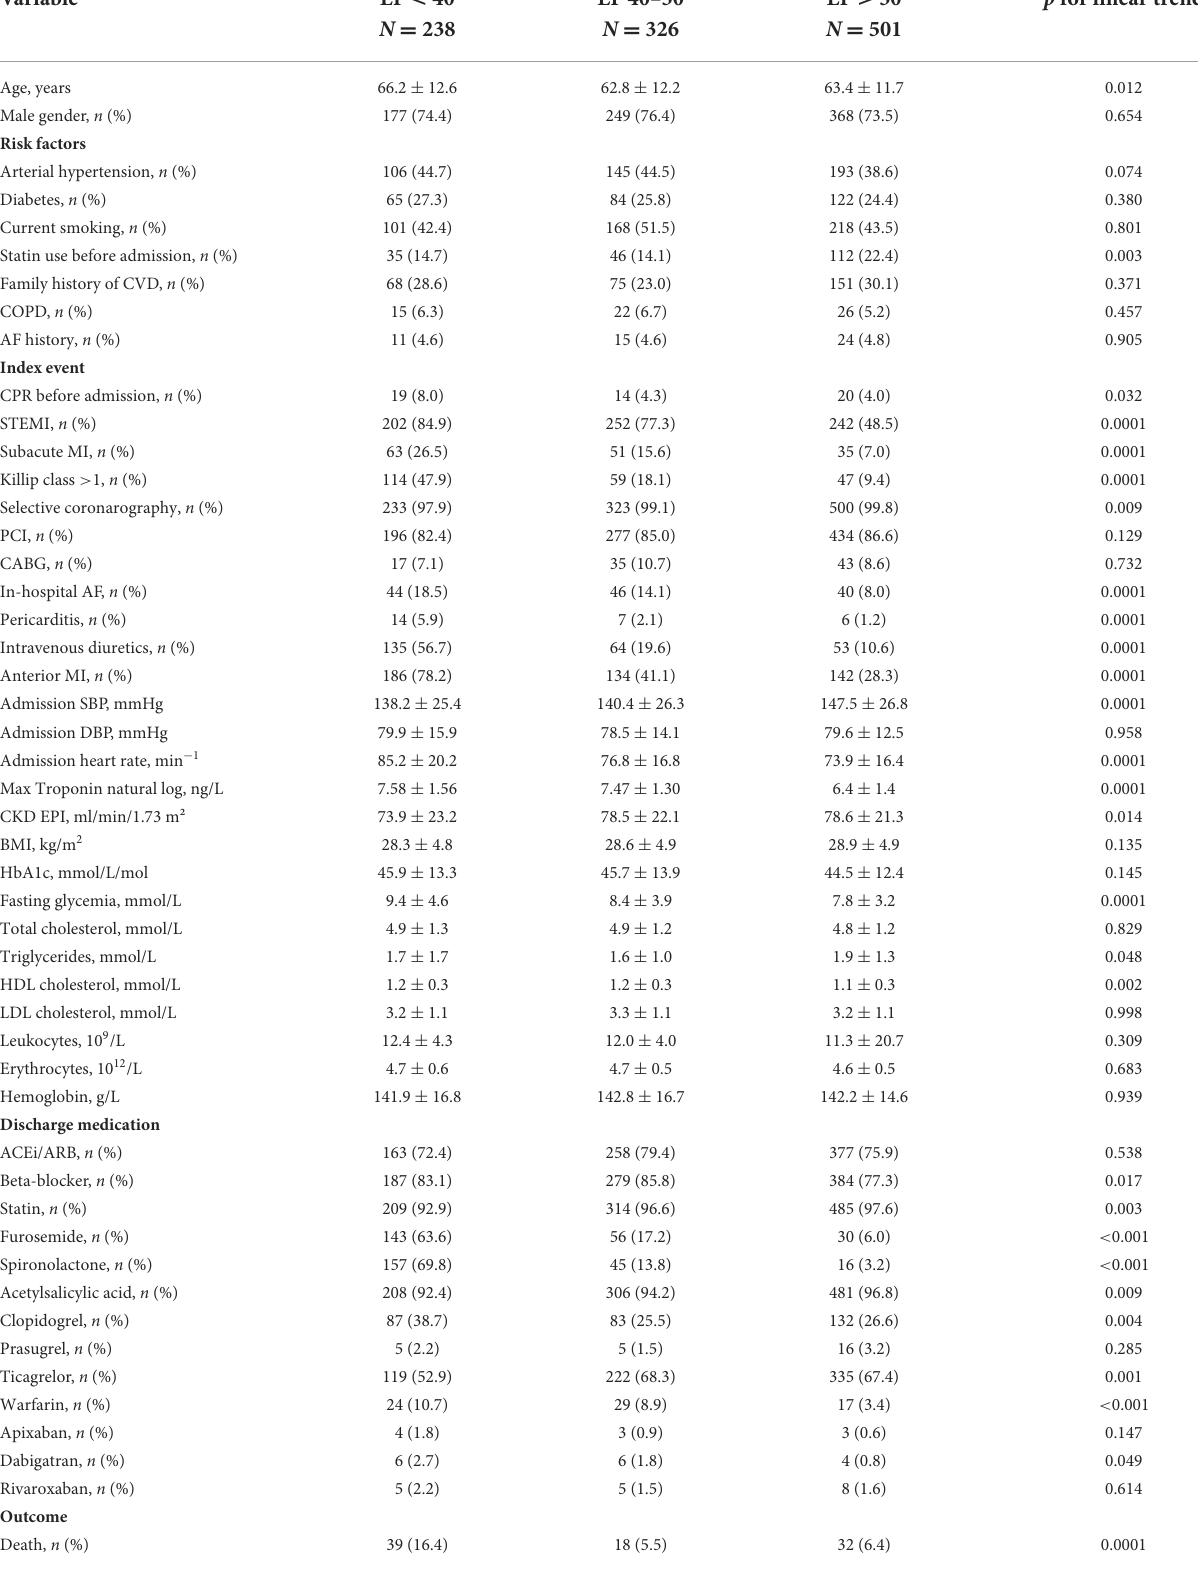
TABLE 1 Population demographics by left ventricular ejection fraction at the time of